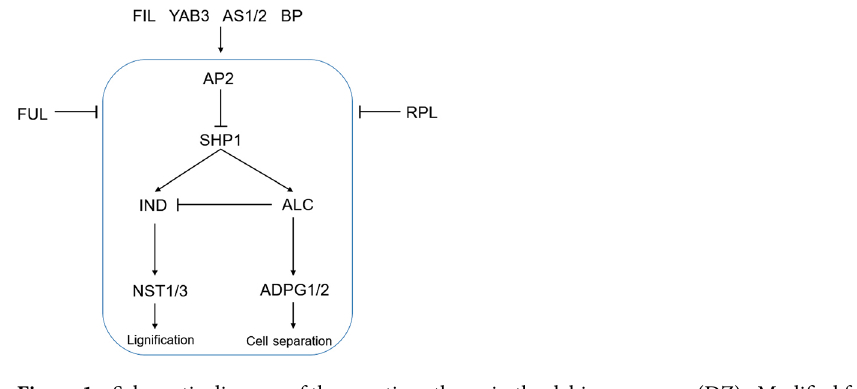
Figure 1. Schematic diagram of the genetic pathway in the dehiscence zone (DZ). Modified from Ballester and Ferrándiz